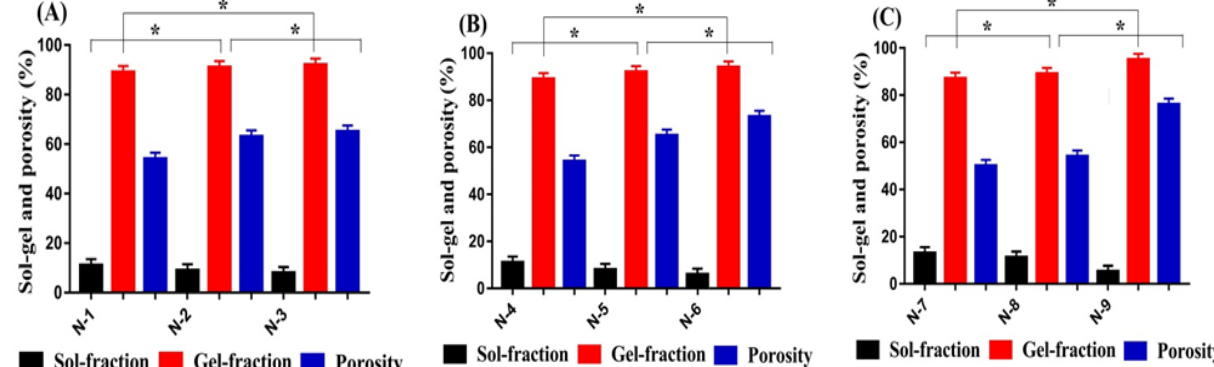
Figure 2. Effect of ( A ) Cs, ( B ) Sps, and ( C ) Aca on sol-gel and porosity of Cs/SpsCpAca hydrogel.